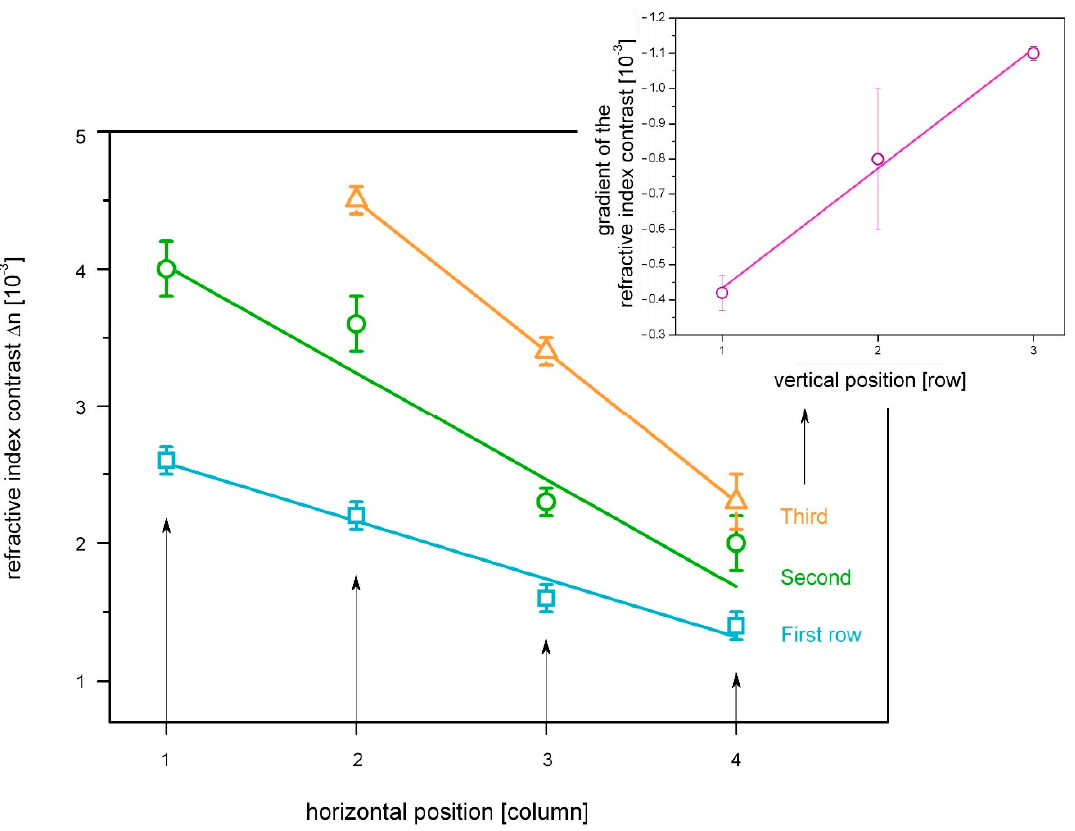
Figure 6. Impact of pre-exposure on the refractive index contrast. All holograms are subsequently exposed, line by line under equal conditions, i.e., in the first row (blue squares), second row (green circles), and the third row (orange triangles). Exposure duration was 15 s for each hologram. The inlay in the upper right shows the gradient of the refractive index contrast from line to line with corresponding linear fit.